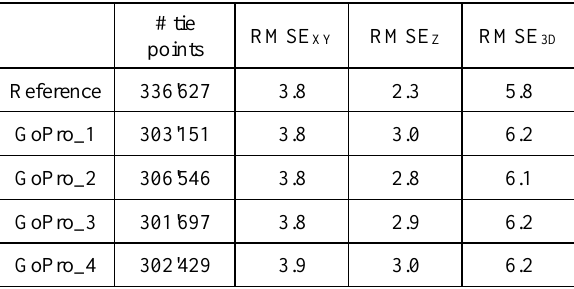
Table 2. Performance during bundle adjustment. GoPro_1 = without CA correction, GoPro_2 = only green channel, corrected using collocation model. RMSE values in